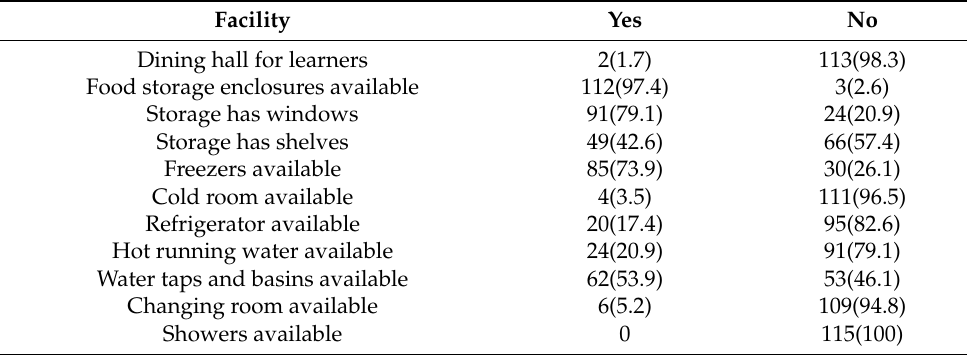
Table 4. Resources available in the food preparation facilities at